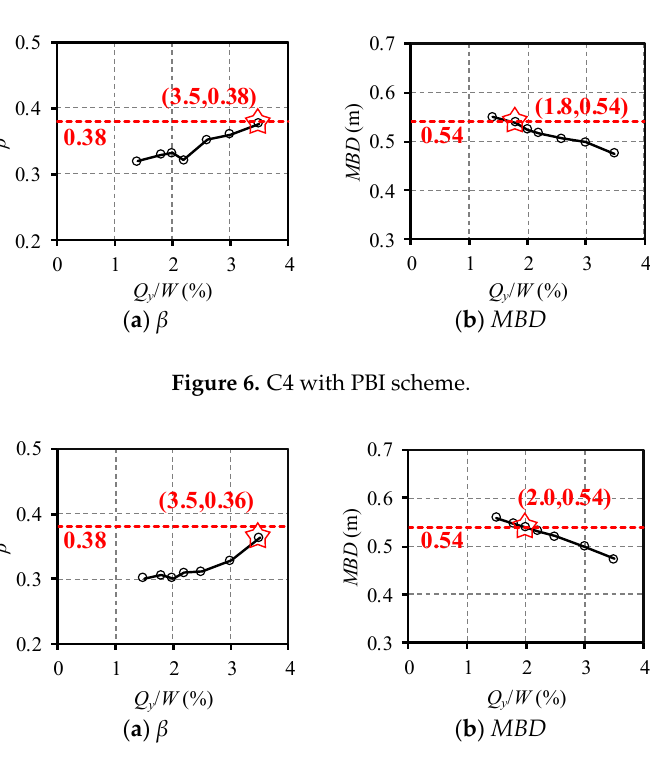
Figure 7. C4 with CBI scheme.